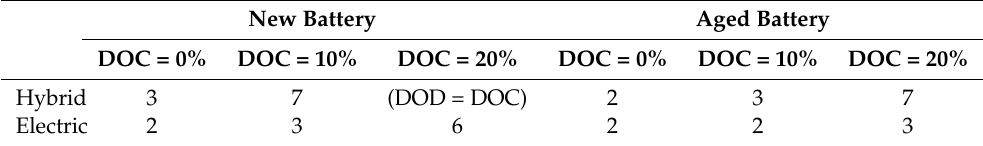
Figure 10. Repeated flights with DOC = 20% for the electric air-taxi with 2035 technology and new battery. The arrow shows the increment of charge (DOC) between the end of flight 1 and the beginning of flight 2. Table 8. Effect of battery aging on the number of consecutive flights.